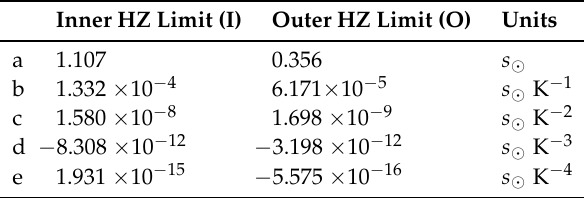
Table 1. Coefficients for the polynomial fit in Equations (3) and (4), from